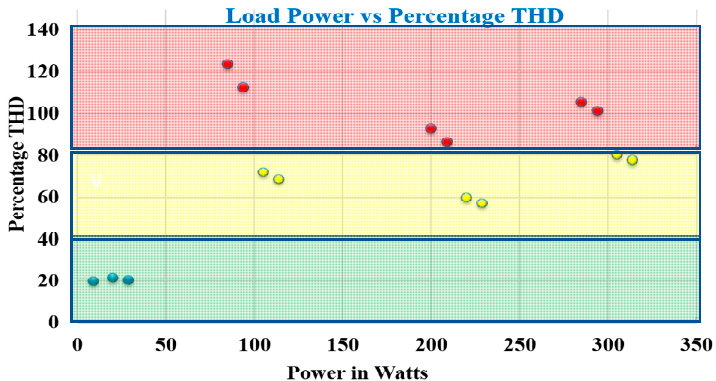
Figure 9. Load power versus percentage THD of the demand.